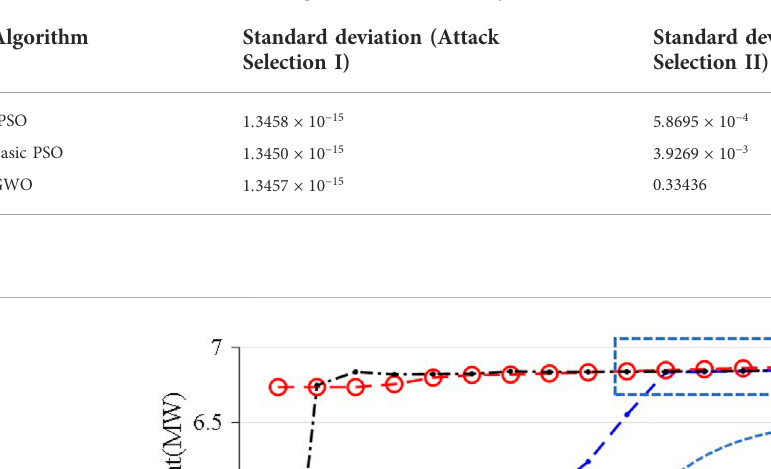
TABLE 5 Simulation results of three algorithms under 50 independent trials.